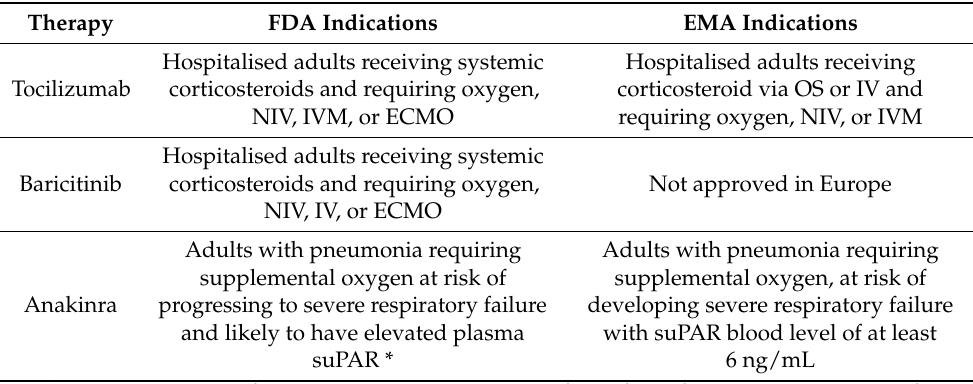
Table 2. Actual indications for severe SARS-CoV-2 pneumonia approved by EMA and